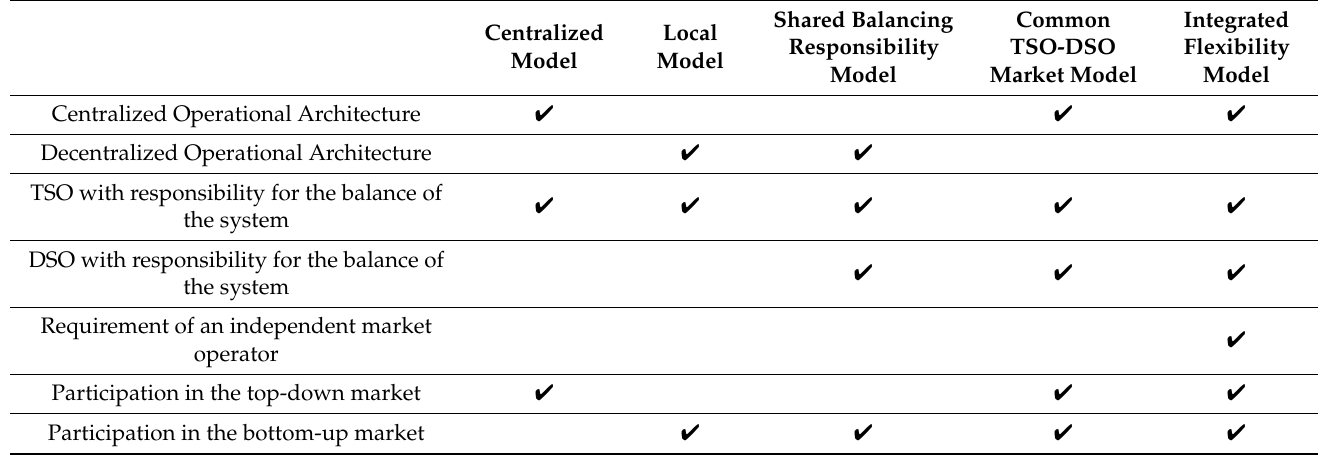
Table 4. Characteristics of coordination models between VPPs and